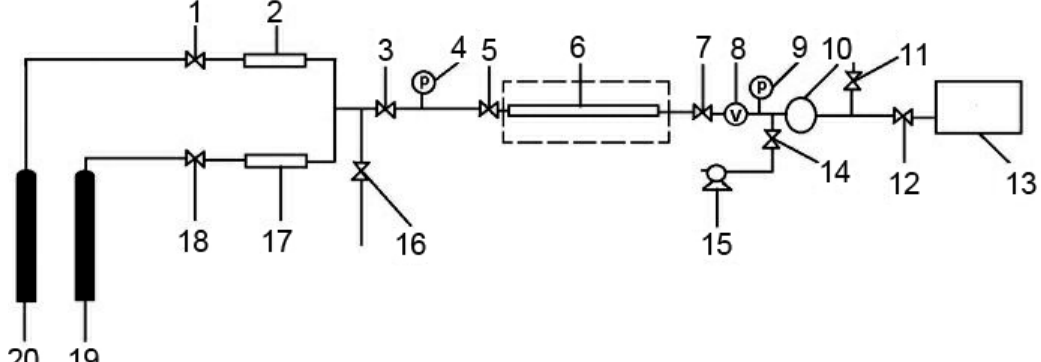
Figure 1. The schematic diagram of self-assembled fixed bed system. 1, 3, 5, 7, 11, 12, 14, 16, 18: cut-o ff